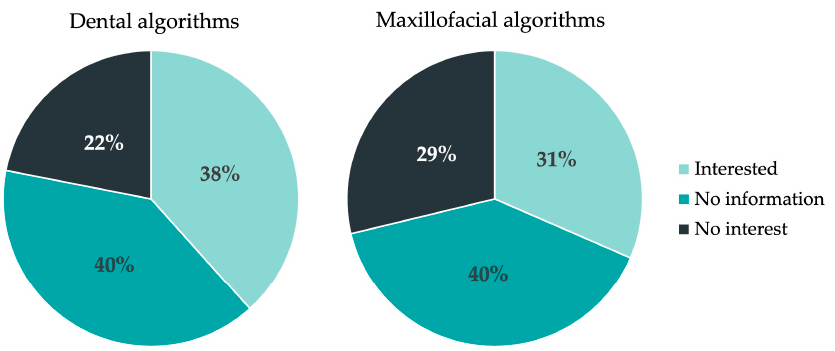
Figure 3. Demand for dental and maxillofacial algorithms in Swiss EDs. At the 36th Swiss Congress of Oral and Cranio-maxillofacial Surgery, we received 27 answers from the participants. Twenty-six percent knew there were dental and maxillofacial “medStandards” and 74% did not know about the availability of these algorithms (Figure 4).